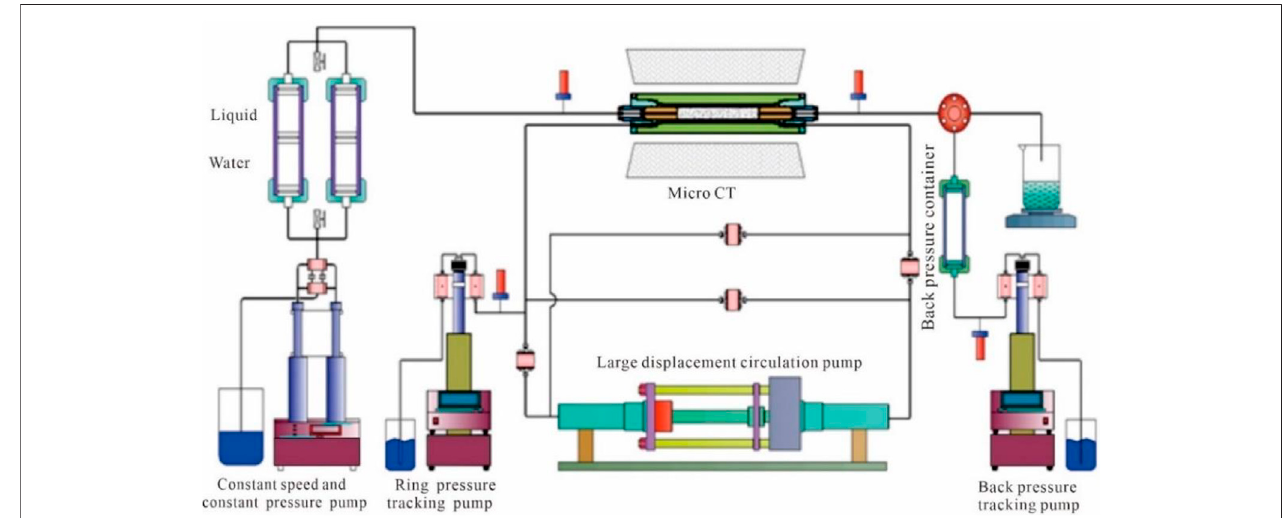
FIGURE 5 | Image of the drive cooperative micron CT scanning device.